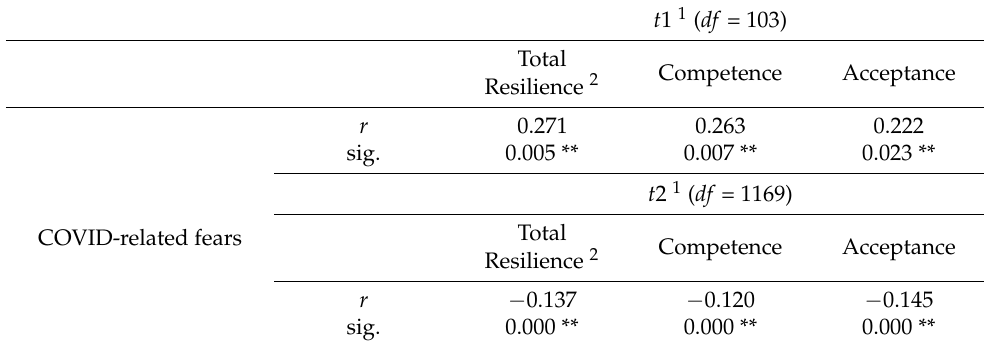
Table 2. Correlations of COVID-related fears with the resilience scales at.